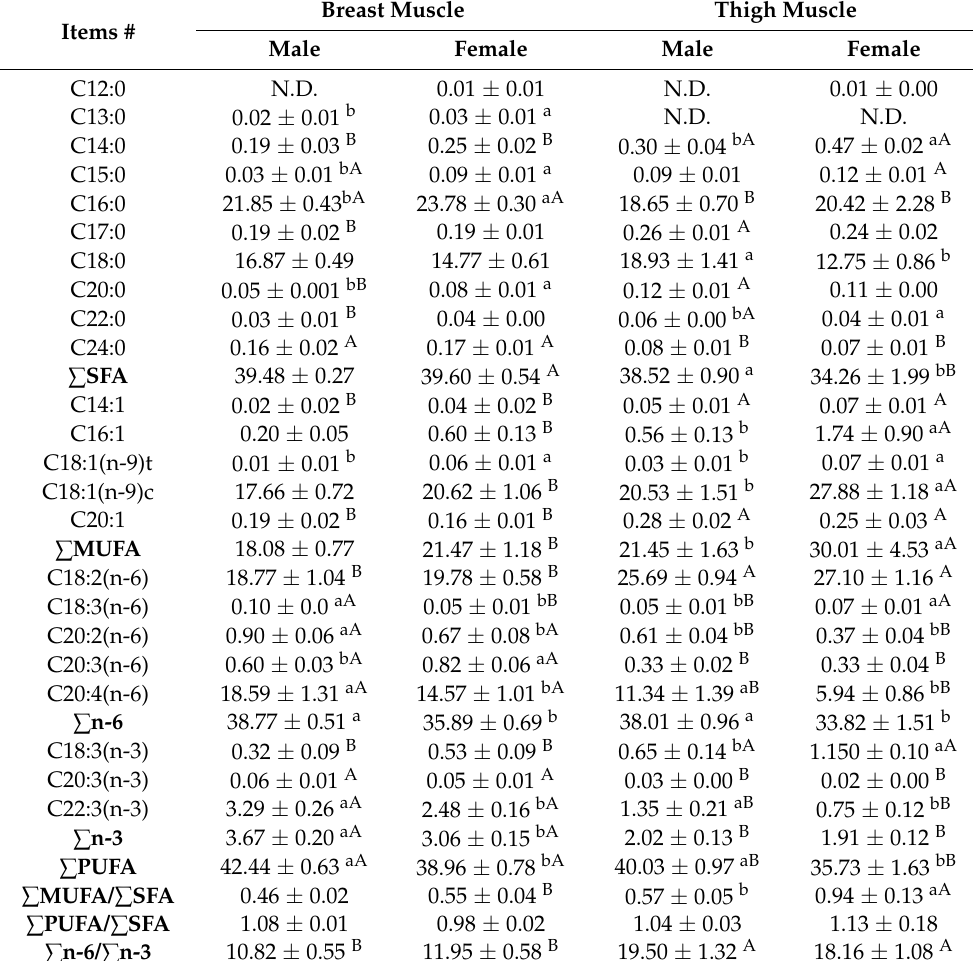
Table 2. The contents of fatty acids in breast and thigh muscles of Wuliangshan Black-bone chickens (%). Breast Muscle Thigh Muscle Items # Male